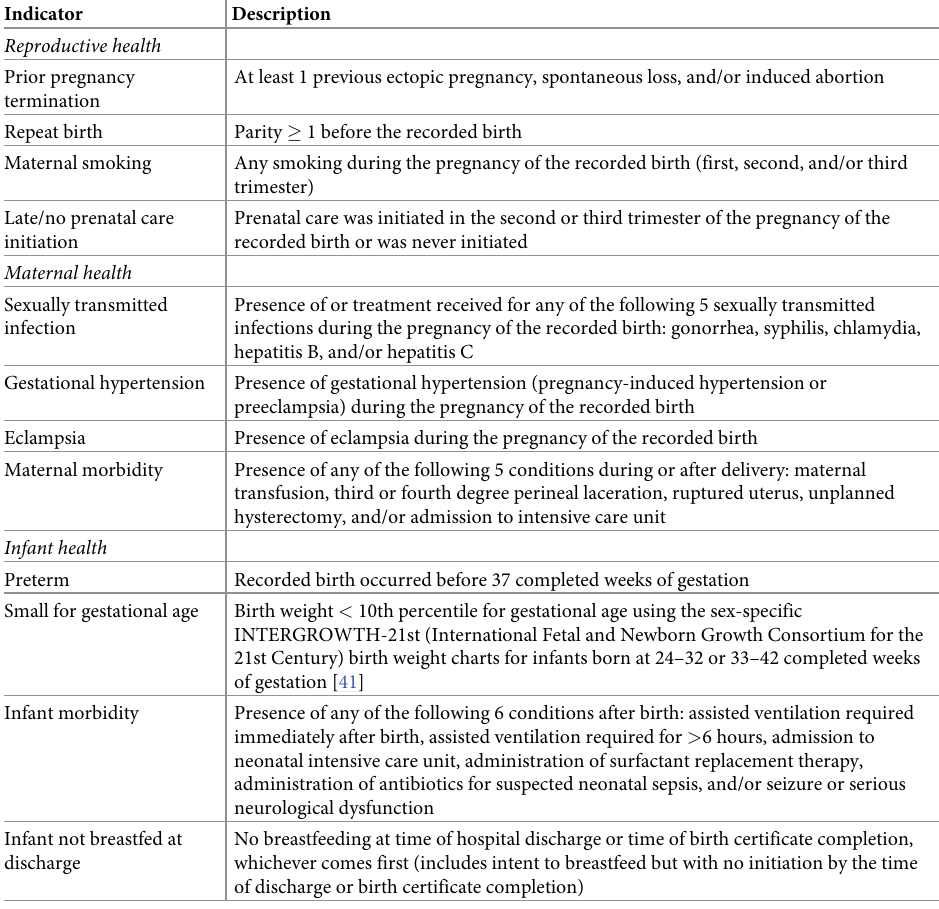
Table 1. Description of the reproductive, maternal, and infant health